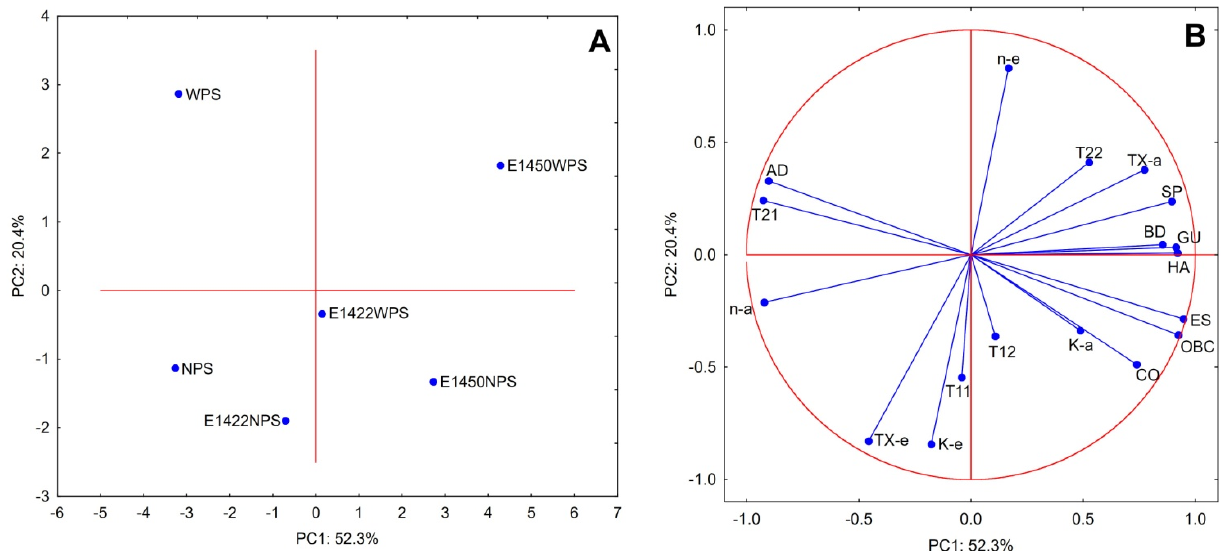
Figure 4. PCA score ( A ); loadings plot ( B ); physicochemical properties of aerogels, as well as